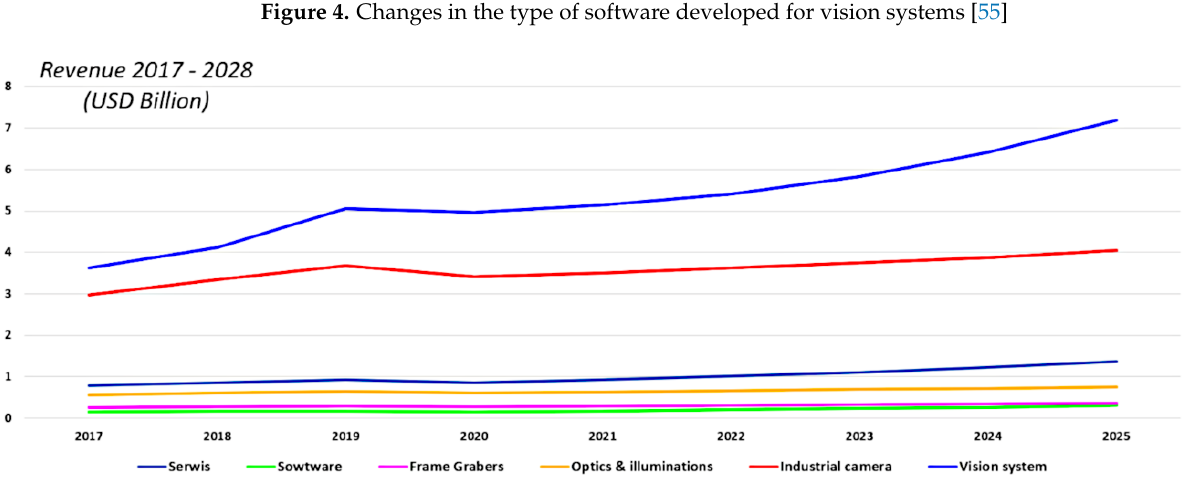
Figure 4. Changes in the type of software developed for vision systems [55]